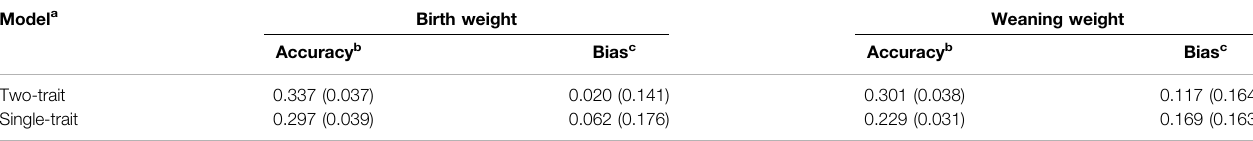
TABLE 4 | Accuracies and biases of genomic prediction and their standard errors (in brackets) under single-trait and two-trait models. Model